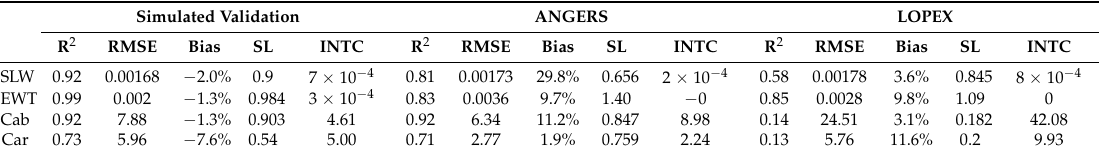
Table 9. The statistical parameters of the validation results for the simulated, ANGERS and LOPEX’93